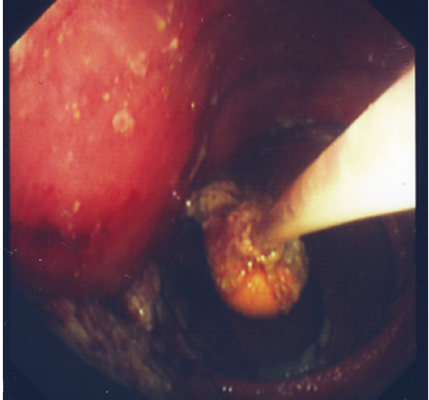
Figure 4: Endoscopic retrieval with a Roth